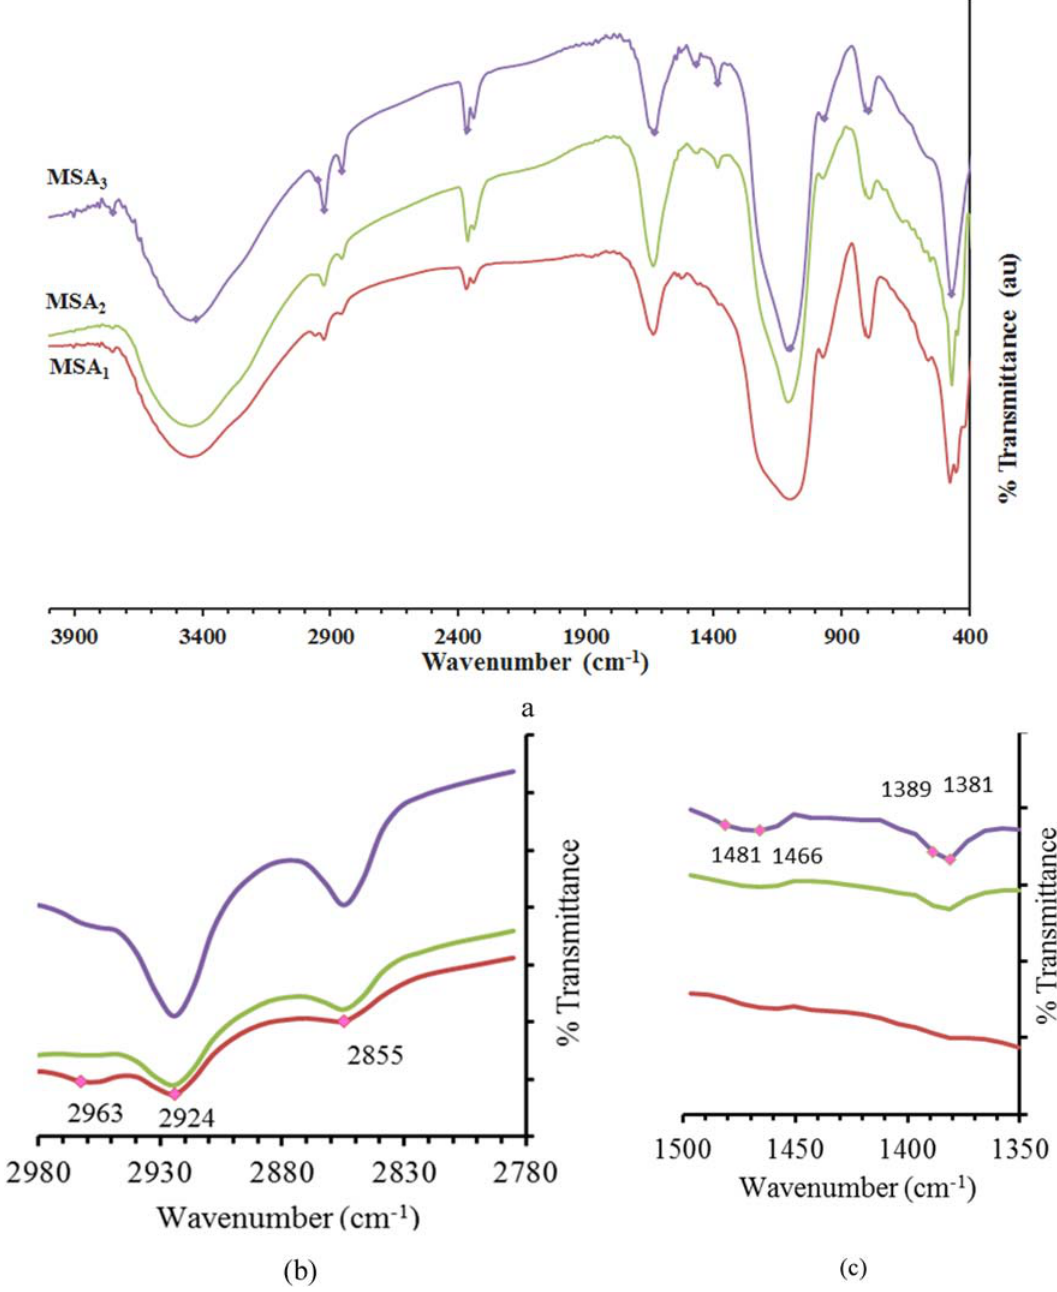
Figure 2: FTIR spectrum result for various MS – CTA: ( a ) all spectra, ( b ) inset spectrum of methylene group of CTAB, and ( c ) inset spectrum of the amine group of